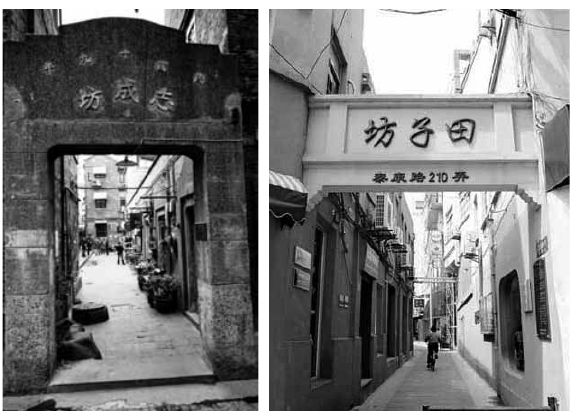
fig. 4. Change of Shikumen houses in linongs in TZf before (left) and after (right) renovation Source: Photo by the first author.